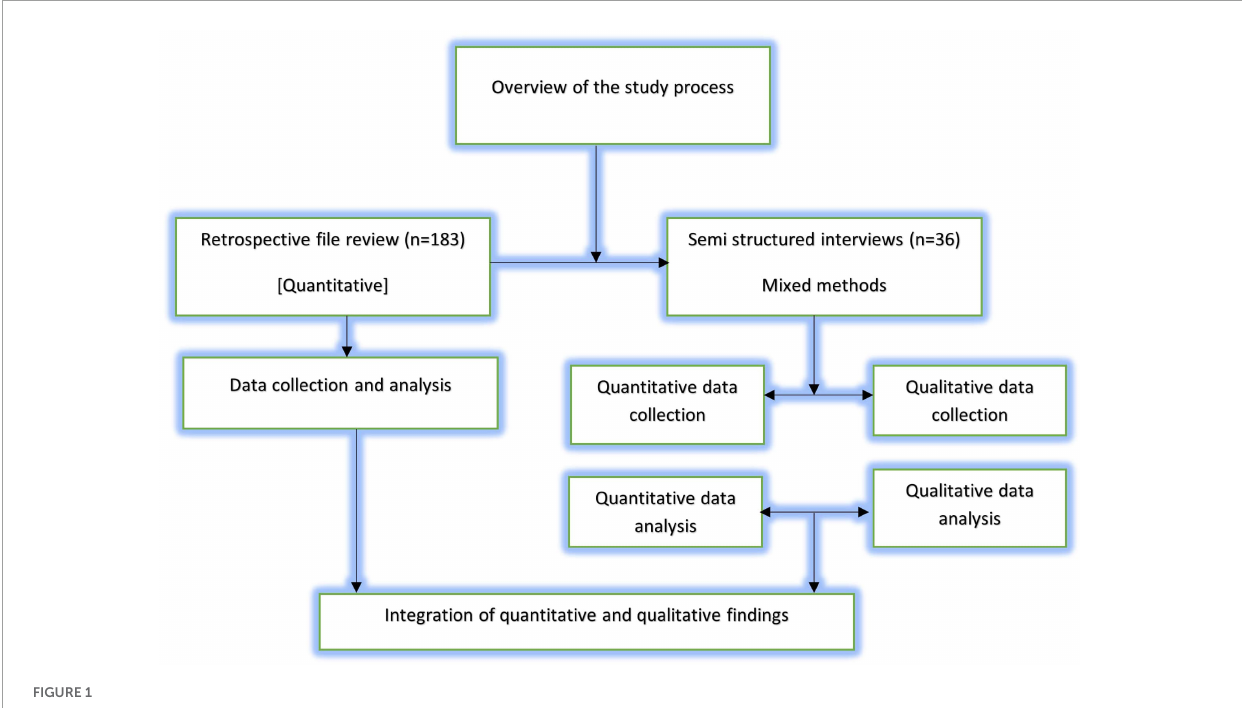
FIGURE1 Overview of the study process.